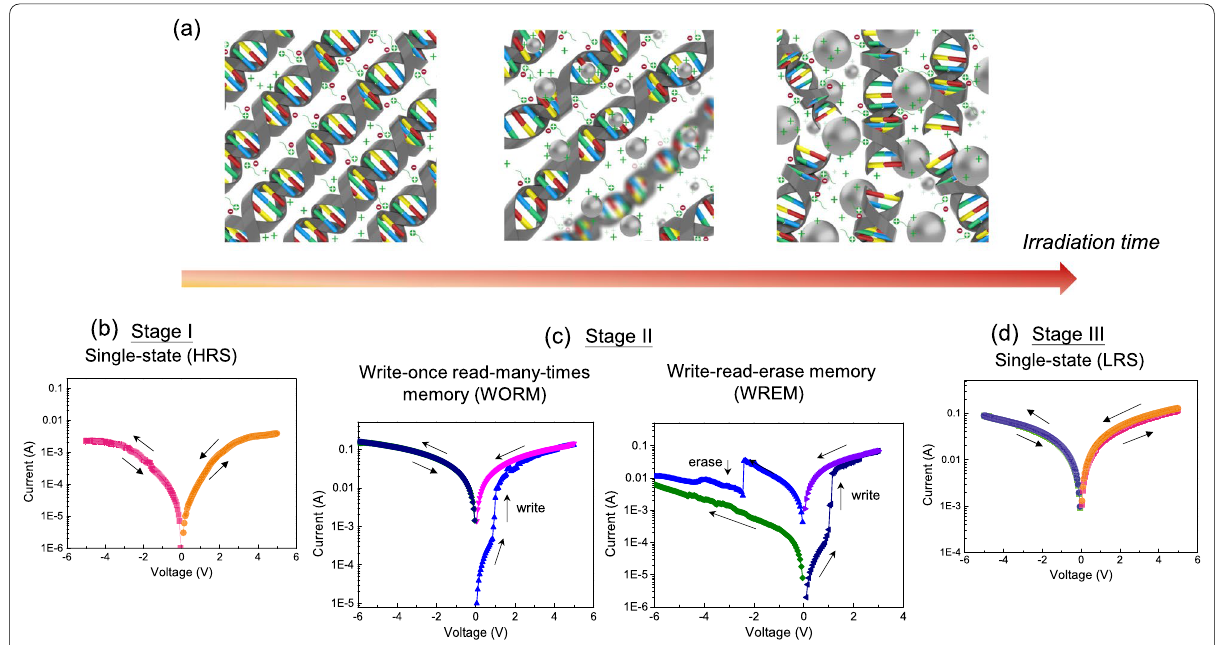
Fig. 5 a Illustration of the phototriggered metallization process in the solid DNA‑CTMA‑Ag matrix. Depending on the irradiation time, the DNA devices exhibit different resistive switching scenarios with single‑state in b and d , and WORM‑type/WREM‑type operations in